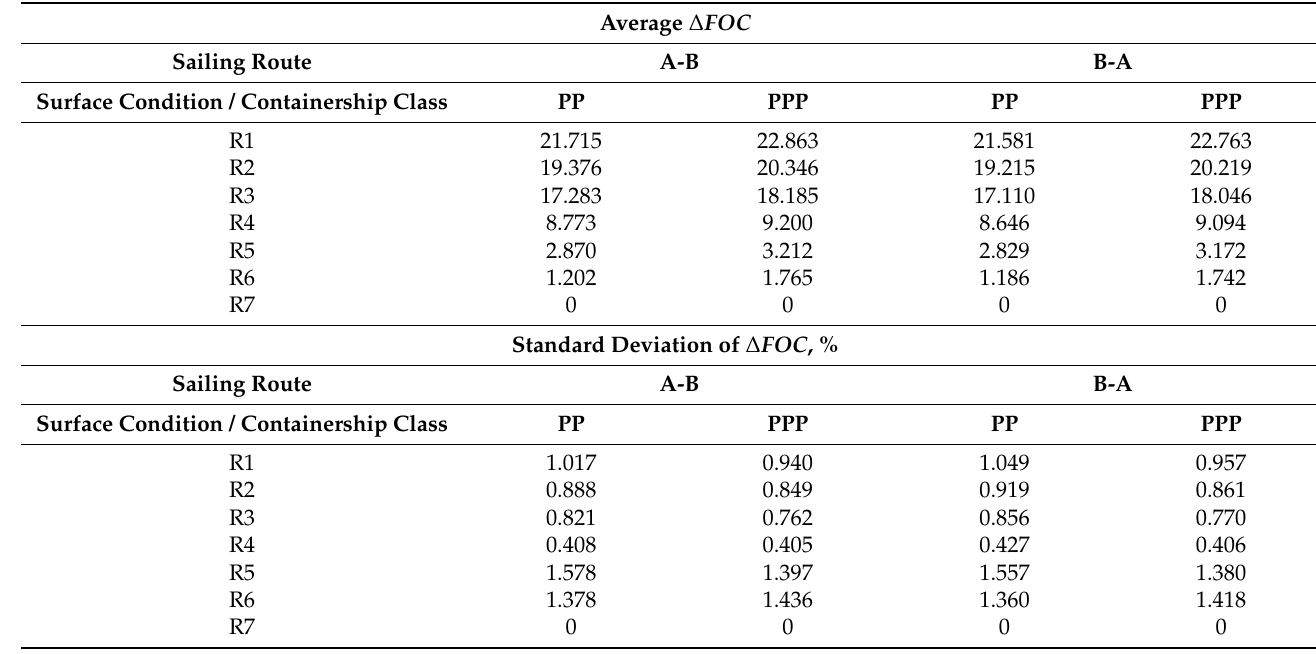
Table 4. The obtained increases in FOC for Post Panamax and Post Panamax Plus container- ship classes.